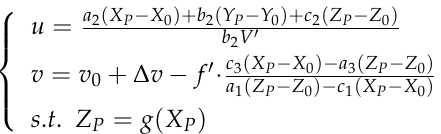
line-scan camera coordinate system O c -X c Y c Z c . The rotation matrix is an orthogonal